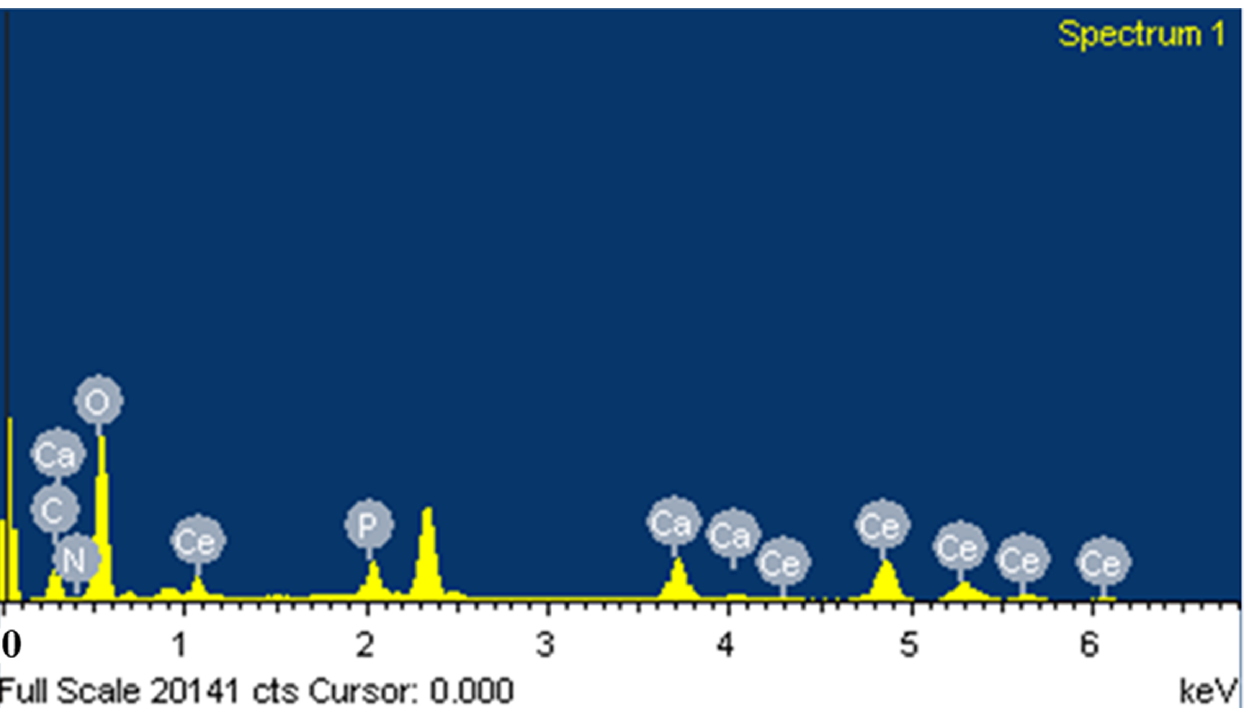
Figure 4. The EDX spectrum of CS-HAP-CeO 2 heterostructure.